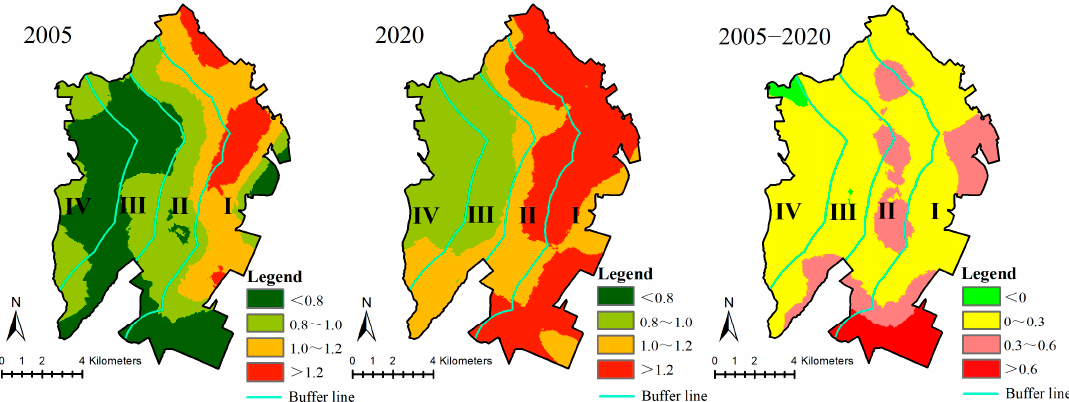
Figure 4. Spatial pattern of ecological risk change. (Gradient I (0–2 km), gradient II (2–4 km), gradient III (4–6 km) and gradient IV (>6 km) from the coastline to the inland).